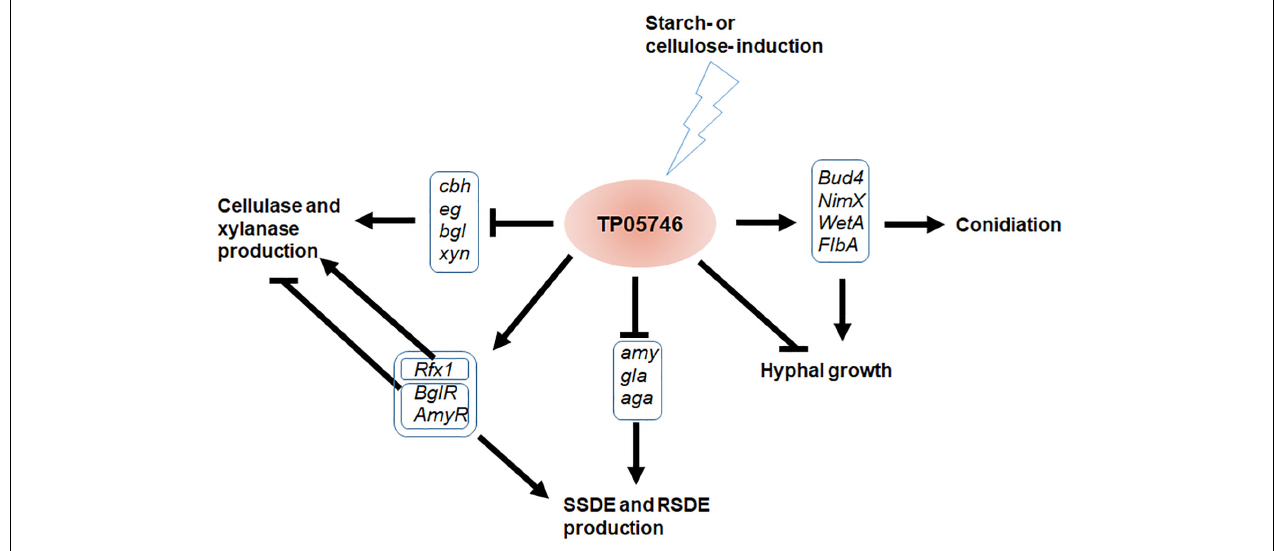
FIGURE 11 | Proposed model of TP05746 regulation in T. pinophilus . cbh , cellobiohydrolase gene; eg , endo- β -1,4-glucanase gene; bgl , β -1,4-glucosidase gene; gla , glucoamylase gene; amy , α -amylase gene; aga , α -glucosidase